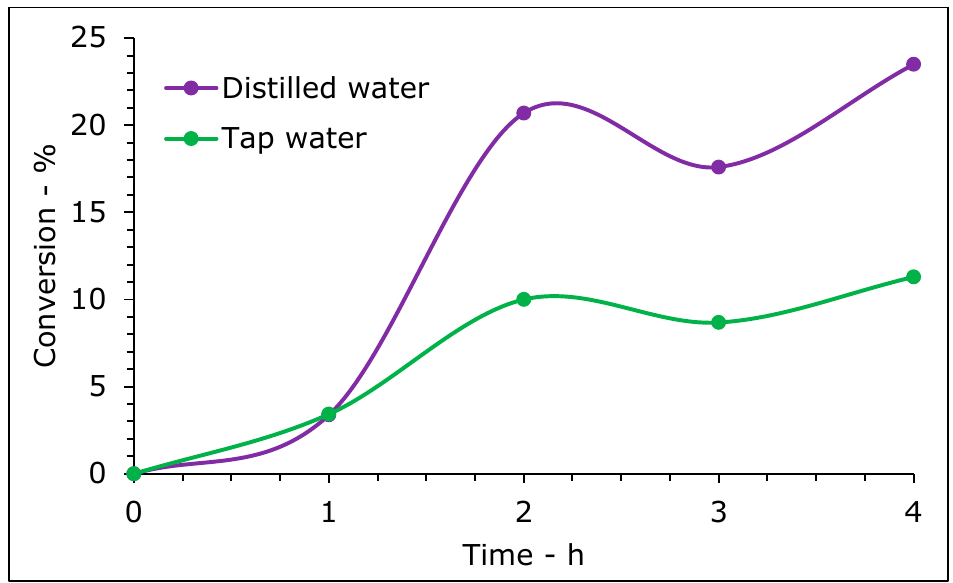
Figure 9. Photo-reduction of NO 3 − under LED lamp using 0.1% Ag/FSP as photocatalyst, sub- strate/catalyst ratio 34 mmol NO3 − /g cat , NaNO 3 (1.7 mM), pH 5, rt and 1000 mL of solution prepared with distilled or tap water (Reactor 2).